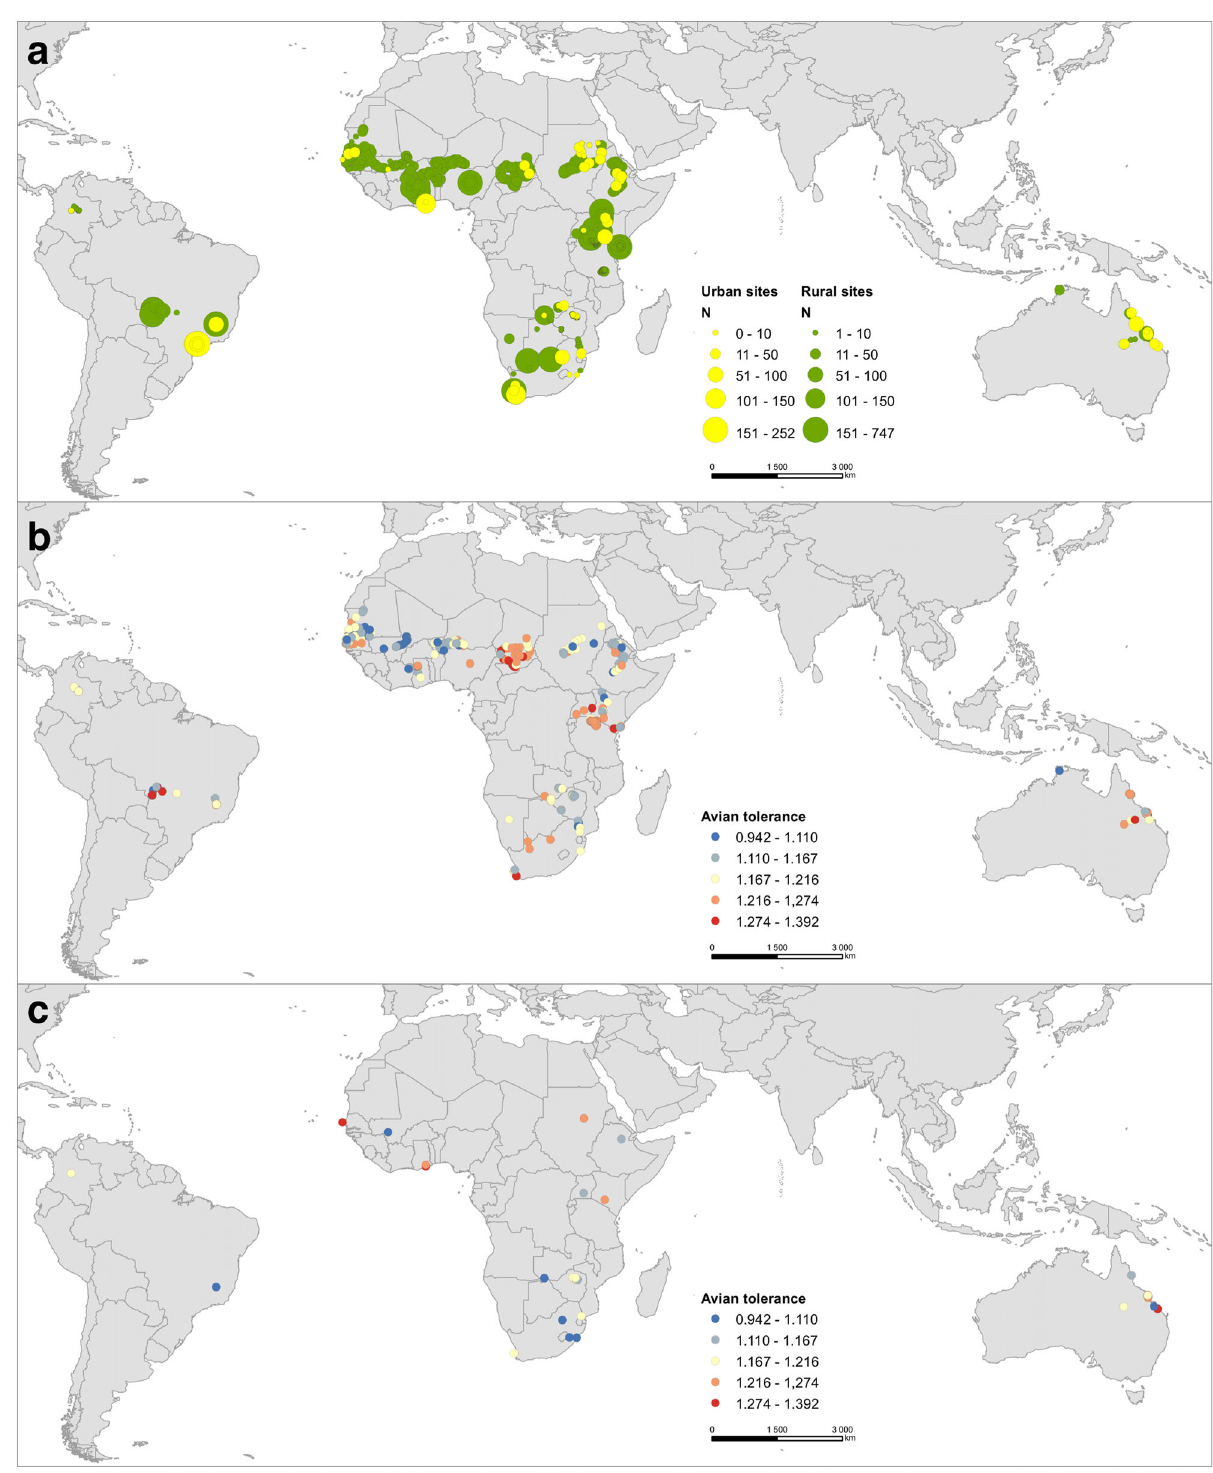
Fig. 1 | Sampling effort and avian tolerance towards humans. a Number of observationsatrural(greencolour)andurban(yellowcolour)sites;thesamplesize is indicated by circle size. b Avian tolerance towards humans across rural and c urban sites. Tolerance towards humans by birds was estimated as residual var- ianceinthe fl ightinitiationdistancepereachsitefromthemainmodel.Redshades indicate lower tolerance of birds towards approaching humans (i.e., birds had longer escape distances), whereas blue shades indicate the opposite. Note that